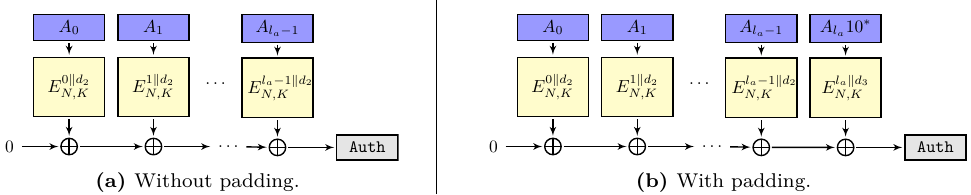
Figure 3: Handling of the associated data: in the case where the associated data is a multiple of the block size, no padding is needed. In the figures, E refers to SKINNY-128-384 . For simplicity, we denote the block counter by 0 . . . , ‘ a − 1 (resp., 0 , . . . , ‘ a ) but actually refer to the state of the LFSRs serving as a block